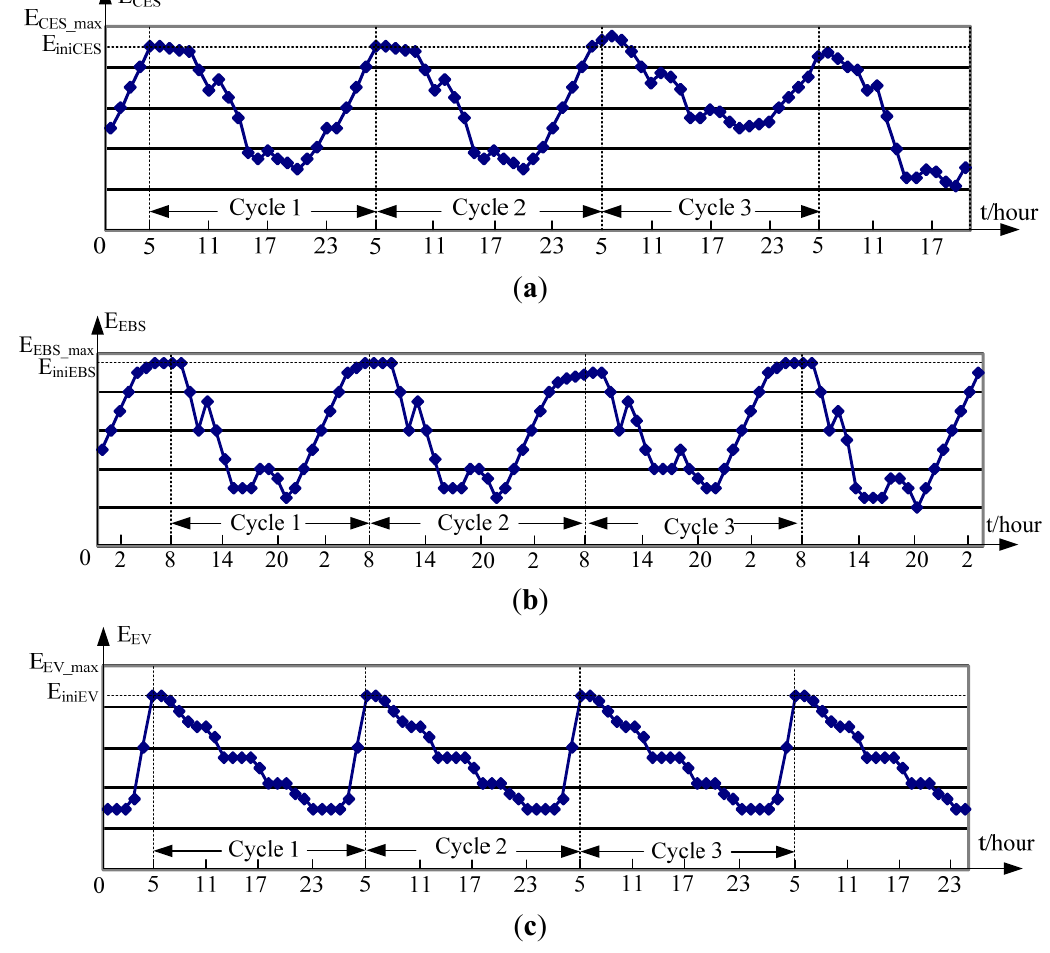
Figure 8. Typical operation curve of generalized energy. ( a ) Generalized energy curve of CES; ( b ) Generalized energy curve of EBS; ( c ) Generalized energy curve of